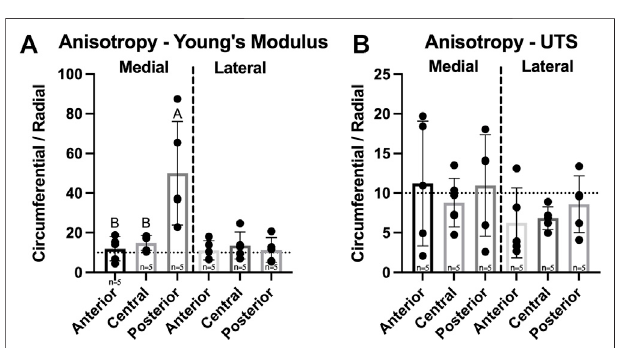
FIGURE 7 | Anisotropy index of Yucatan minipig meniscus tensile properties. (A,B) Anisotropy indices are shown for tensile Young ’ s modulus and UTS, respectively. Student ’ s t-test showed a signi fi cant difference in Young ’ s modulus anisotropy values between menisci. One-factor ANOVA showed the posterior region of the medial meniscus was signi fi cantly more anisotropic in tensile stiffness than its other regions, while no signi fi cant differences were seen among regions of the lateral meniscus. All data are presentedasmeans±standarddeviations.Statisticalsigni fi canceisindicated by bars not sharing the same letters within the same meniscus; additionally, horizontal dotted lines on the Y-axis represent human meniscus values from the literature for comparison to the minipig (Makris et al.,